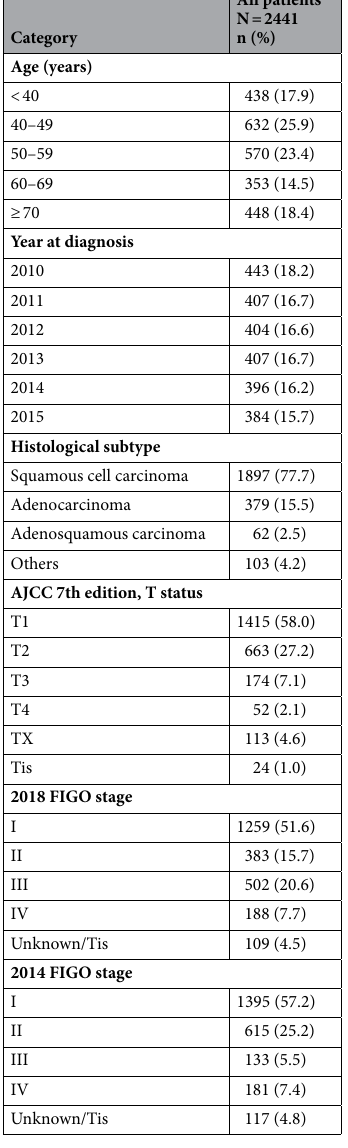
Table 1. Baseline characteristics of Korean patients with cervical cancer. FIGO International Federation of Gynecology and Obstetrics, AJCC American Joint Committee on